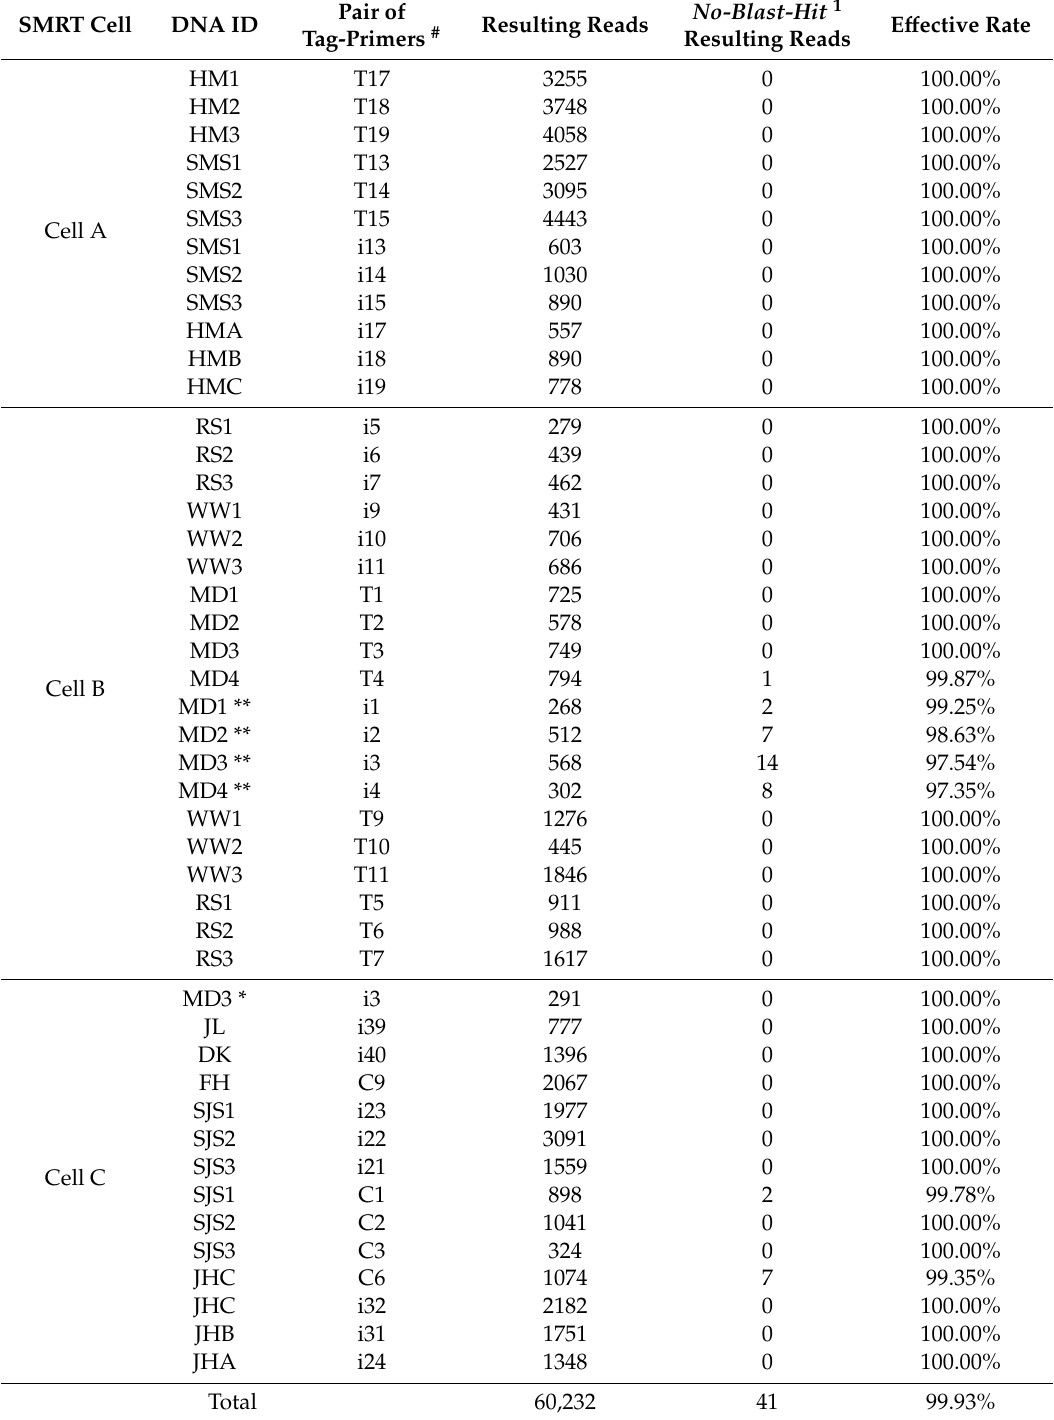
Table 3. Amplicons’ information in di ff erent SMRT cells and e ff ective rate for each